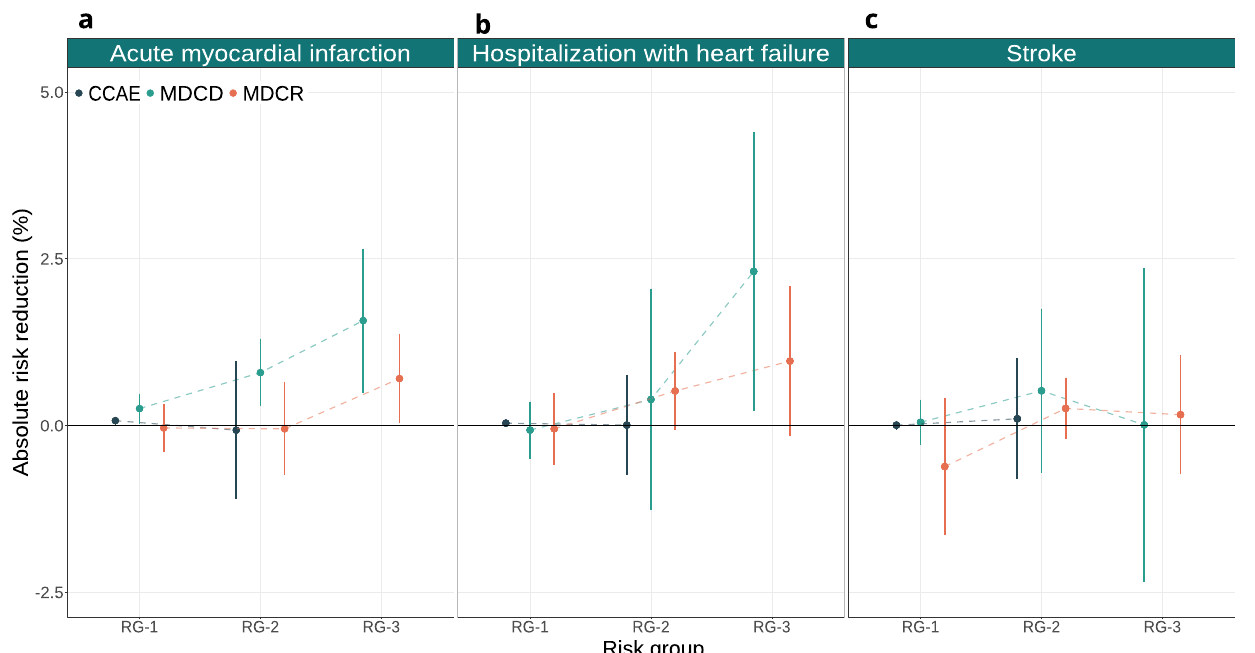
Fig. 6 Absolute treatment effects for main outcomes. Treatment effect heterogeneity for the main outcomes on the absolute scale of thiazide or thiazide-like diuretics compared to ACE inhibitors within strata of predicted acute MI risk. In a we present treatment effects on the absolute scale for acute MI within groups of predicted acute MI risk across all three databases. In b we present treatment effects on the absolute scale for hospitalization with heart failure within groups of predicted acute MI risk across all three databases. In c we present treatment effects on the absolute scale for stroke (both ischemic and hemorrhagic) within groups of predicted acute MI risk across all three databases. RG-1 represents the group of patients with acute MI risk below 1%; RG-2 represents the group of patients with acute MI risk between 1% and 1.5%; RG-3 represents the group of patients with acute MI risk larger than 1.5. Absolute treatment effects estimated in CCAE, MDCD, and MDCR are represented by blue, green, and orange circles, respectively. The bars represent 95% con fi dence intervals. Values above 0 favor thiazide or thiazide-like diuretics, while values below 0 favor ACE